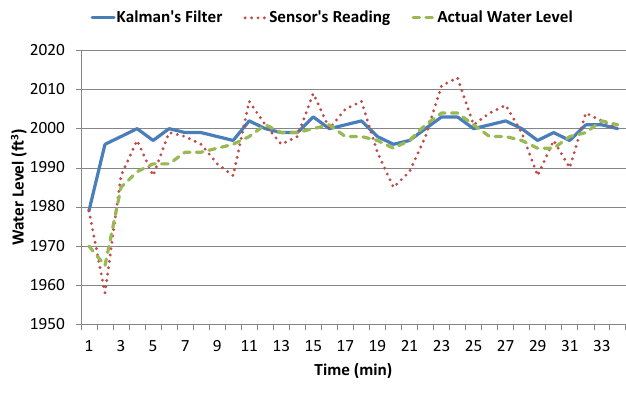
Figure 12. Kalman filter optimization of desired water levels.